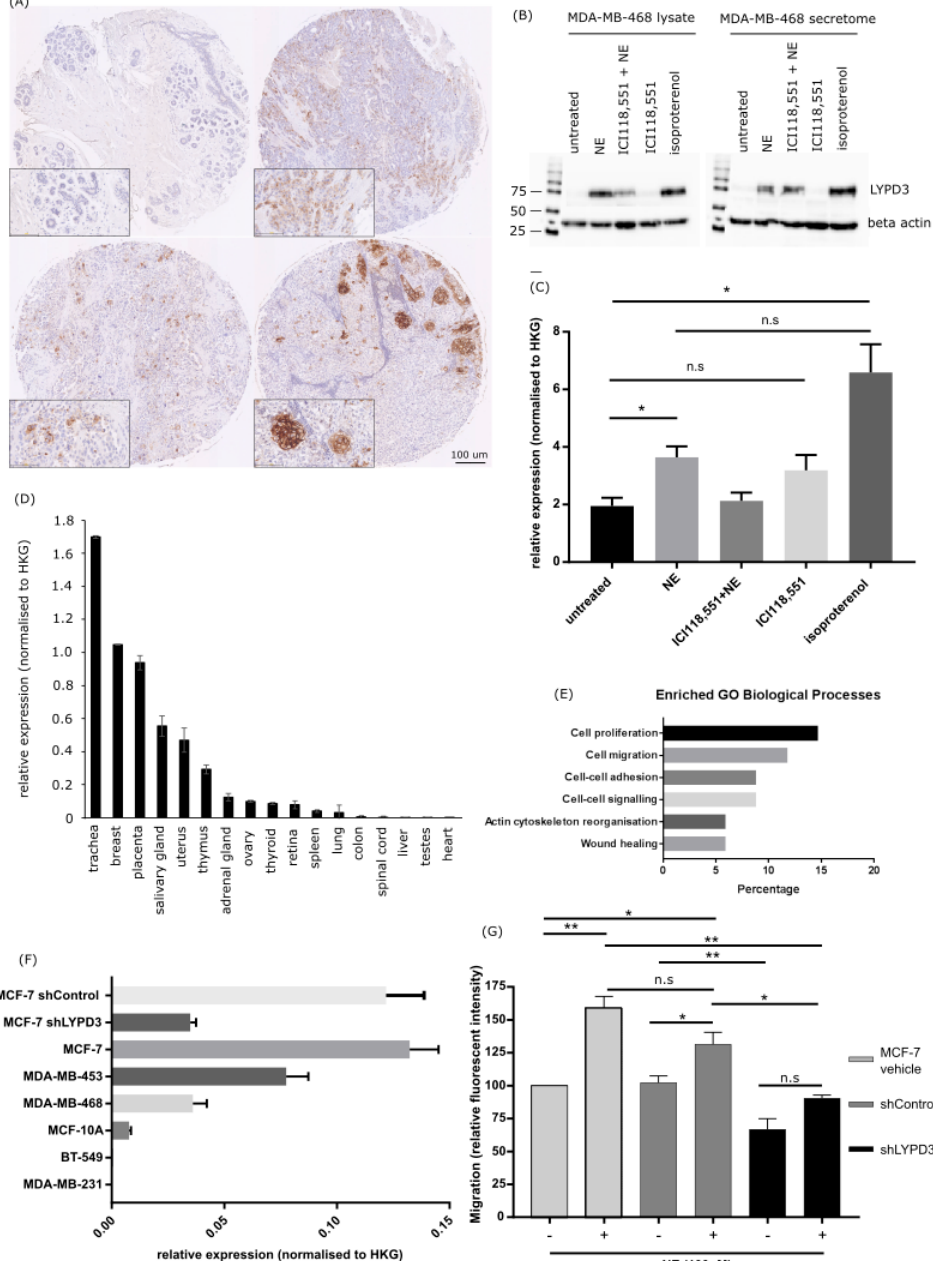
Figure 3. LYPD3 expression in breast patient TMAs (tumour micro arrays), breast cancer cell lines and a normal tissue RNA panel and the effects of LYPD3 gene knockdown. ( A ) IHC (immunohistochemistry) staining of LYPD3 in (top left) normal breast, (top right) invasive ductal carcinoma (TN, grade 3, stage I), (bottom left) invasive ductal carcinoma (TN, grade 3, stage IIA), (bottom right) lymph nodes metastases from patients with invasive ductal carcinoma. ( B ) Western blot of LYPD3 expression in 50 µg protein extracted from the cell lysate (left hand panel) or secretome (right hand panel) of MDA-MB-468 cells following treatment demonstrated an upregulation of LYPD3 protein following treatment with norepinephrine or isoproterenol alone and also following concomitant treatment with ICI118,551. ( C ) LYPD3 gene expression level in MDA-MB-468 cells following treatment demonstrates a significant upregulation of LYPD3 in norepinephrine and isoproterenol stimulated MDA-MB-468 cells. Results shown are the mean ± standard deviation. Statistical analysis was performed using an un-paired Student’s T-test. * p < 0.05, ** p < 0.01. ( D ) LYPD3 gene expression levels (relative to the house